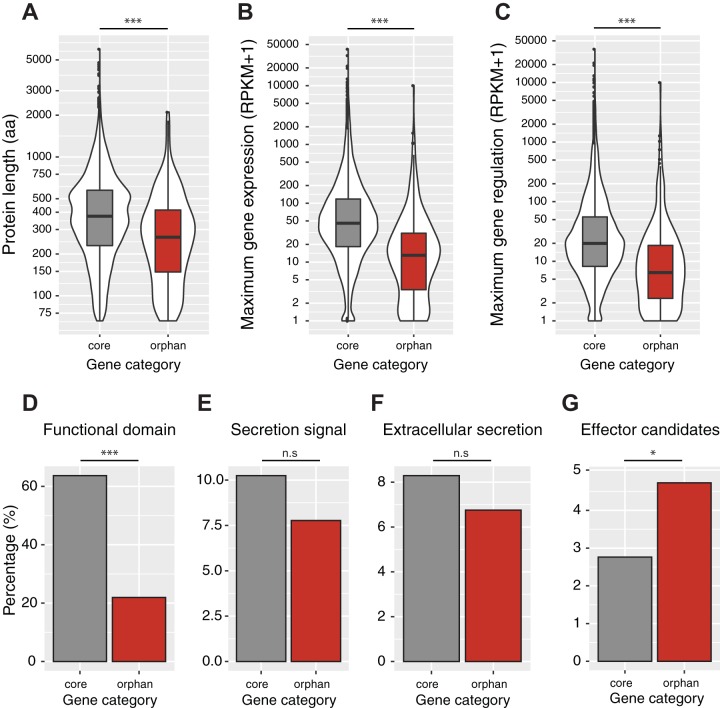
Differentiation of core and orphan genes in the 3D7 genome. (A) Orphan genes encoded significantly smaller proteins (Wilcoxon rank sum, P < 0.0001). (B and C) Orphan genes were significantly less transcribed during the infection of wheat leaves (B), and the difference between the minimum and maximum transcription levels was smaller (C) (Wilcoxon rank sum, P < 0.0001). (D) Orphan genes were less likely to encode a protein associated with a protein family (Pfam) domain (Fisher exact test, P < 0.0001). (E and F) Core and orphan genes were similarly likely to encode secreted proteins (E) and proteins targeted for extracellular secretion (F). (G) Orphan genes were more likely to encode candidate effectors based on classifications by EffectorP (43) (Fisher exact test, P = 0.0496).